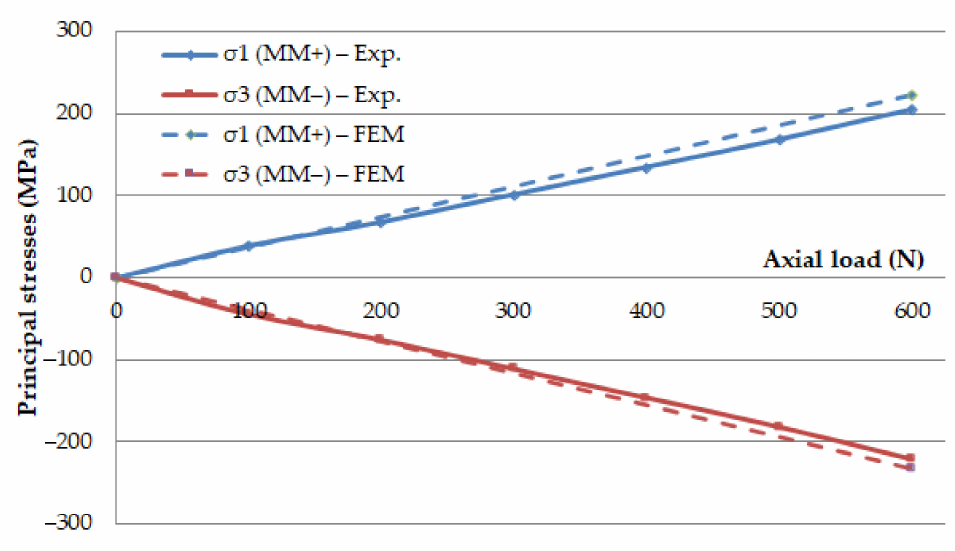
Figure 10. Comparative diagram of the principal stresses ( σ 1 on MM+) and ( σ 3 on MM − ) for configuration